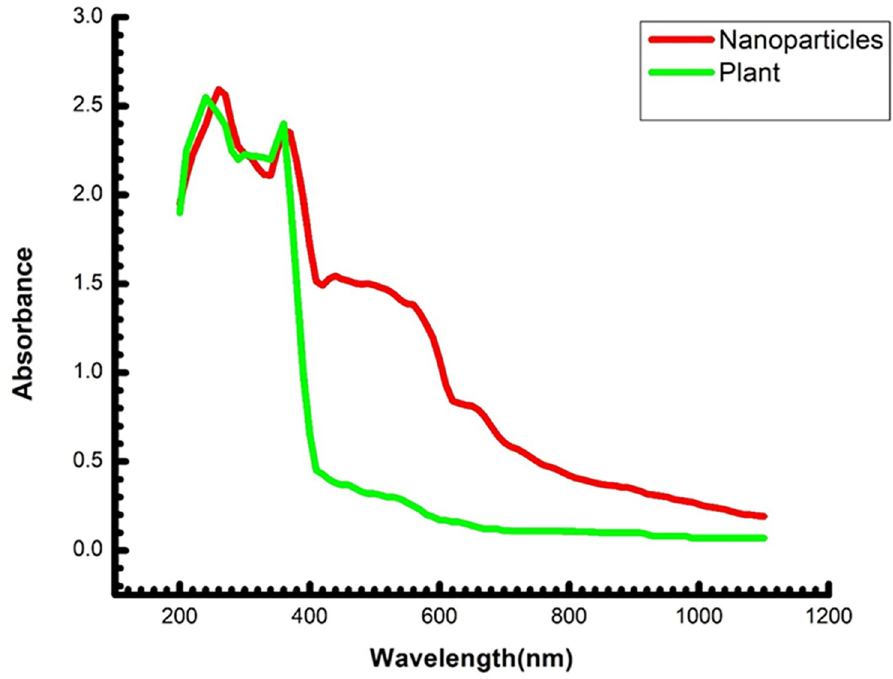
Fig 2. UV-vis spectra of plant extract (green) and silver nanoparticles (red).